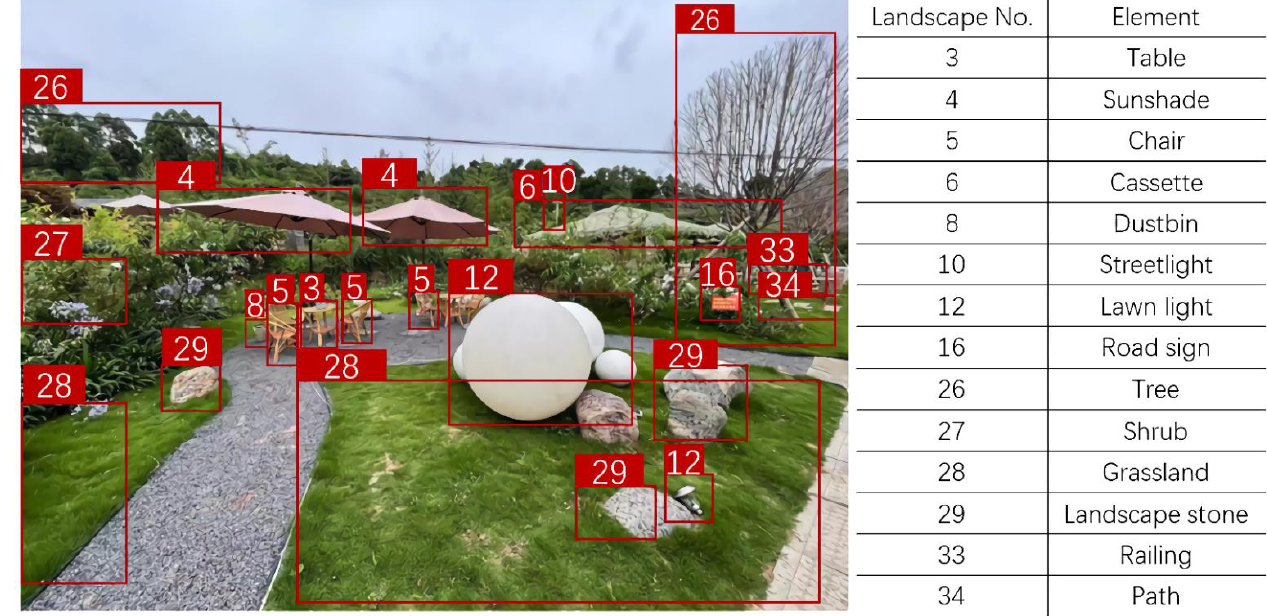
Figure 1. Object detection model data recognition diagram.